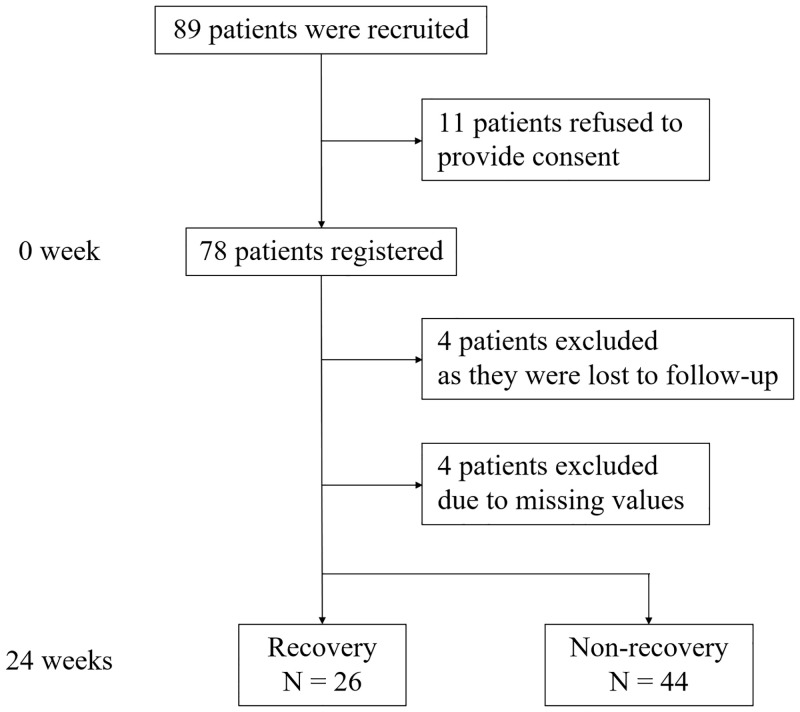
Consort diagram.